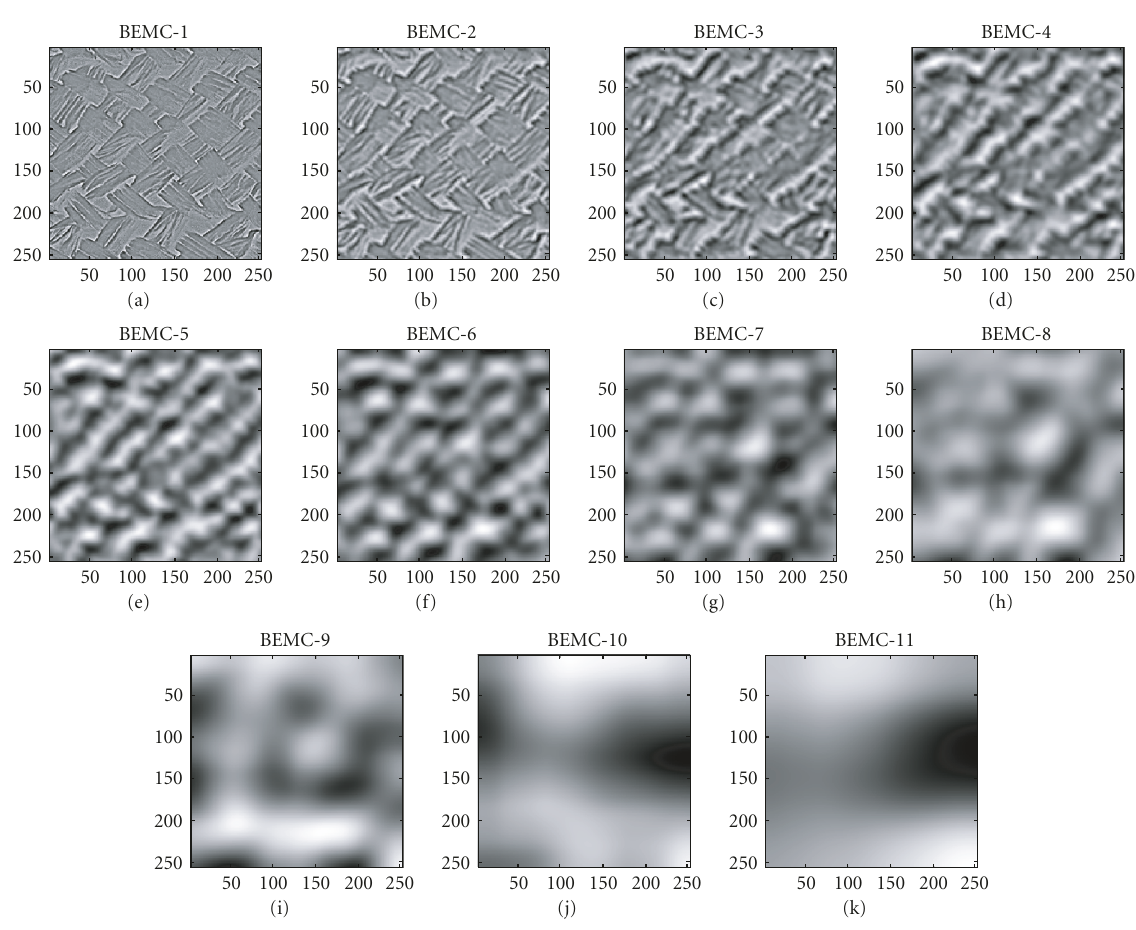
Figure 19: BEMCs of D18 obtained by FABEMD with Type-1 OSFW (MNAI = 1).